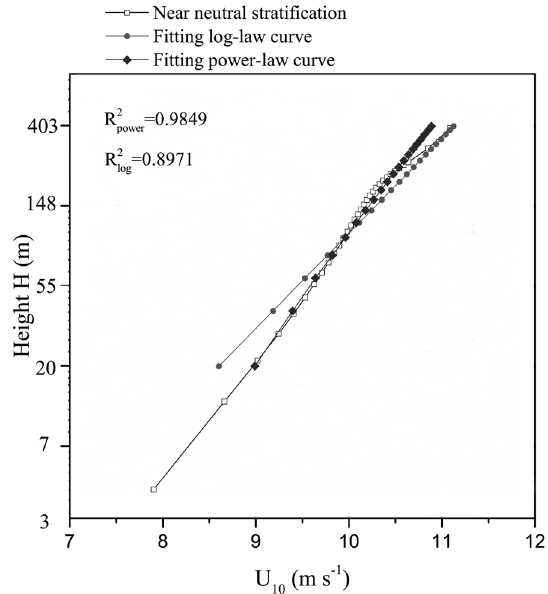
Figure 13. The near-neutral wind profile and corresponding log-law and power-law fitting curves. (cid:1844) (cid:3043)(cid:3042)(cid:3050)(cid:3032)(cid:3045)(cid:2870) and (cid:1844) (cid:3039)(cid:3042)(cid:3034)(cid:2870) are the coefficient of determination for the linear regression.